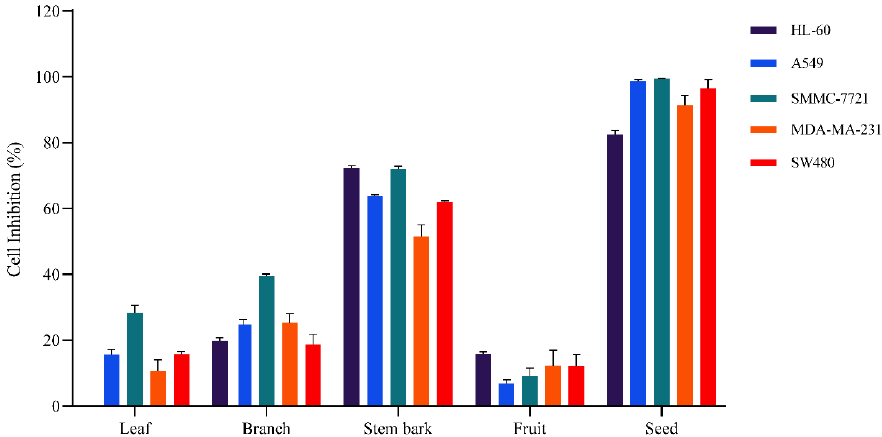
Figure 1. Cytotoxicity assay of different parts of G. xanthochymus against five human cancer cells (HL-60, A549, SMMC-7721, MCF-7, and SW480). Table 1. Cytotoxic effects of seed extract in IC 50 (μg/mL) a .